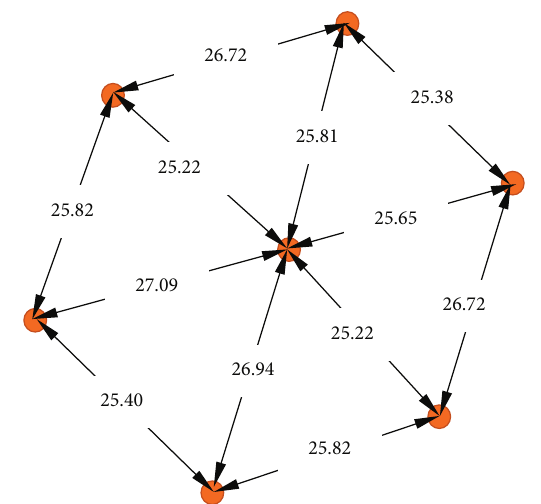
Figure 2: The top view of element centers with interelement spacings (unit is in